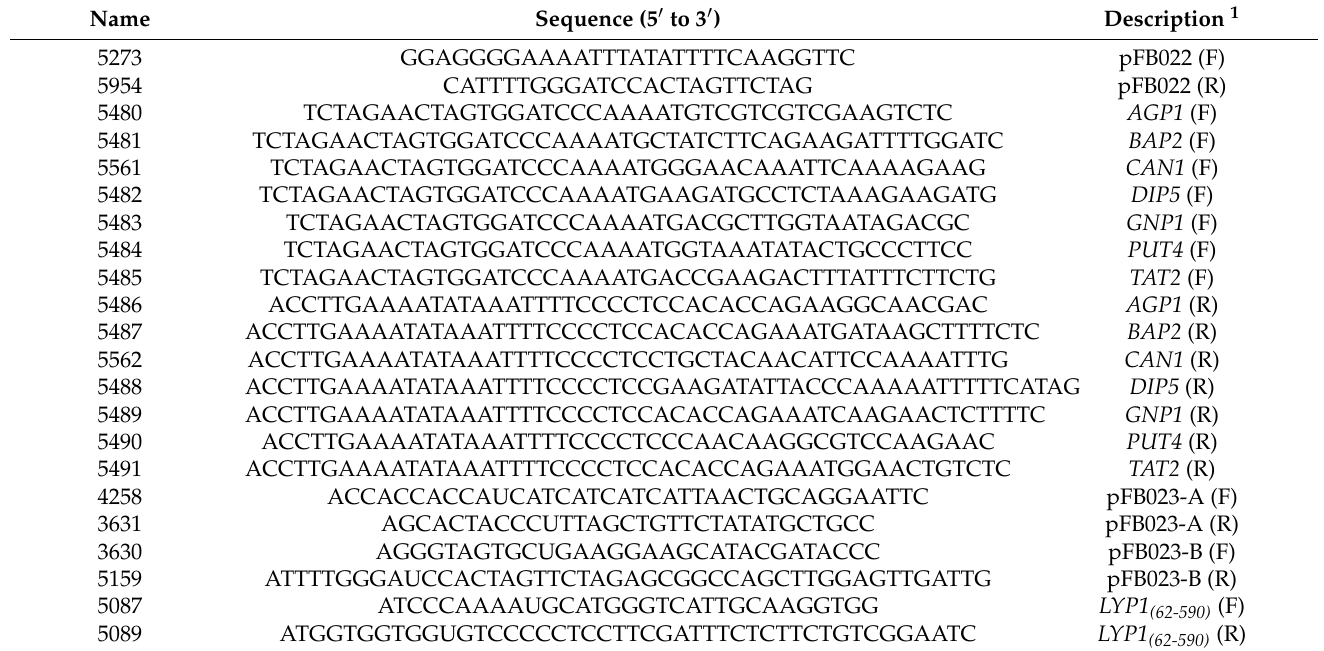
Table 3. Oligonucleotide primers used in PCR